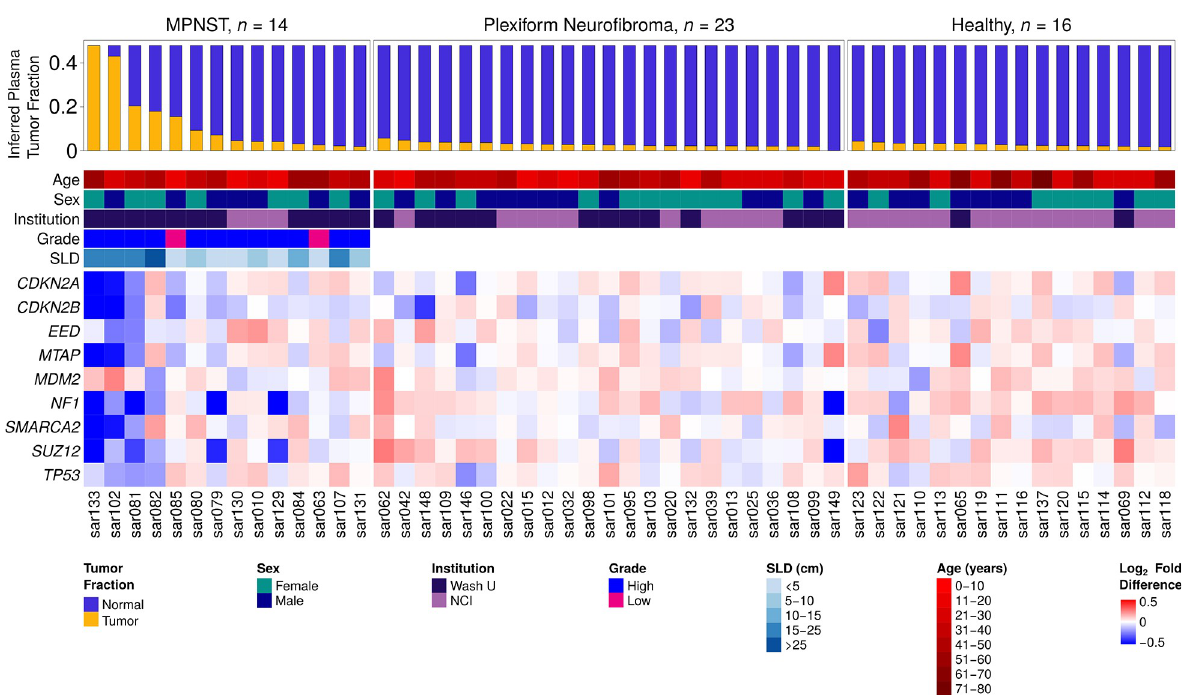
Fig 2. Participant characteristics and CNAs. Heatmap includes all 53 participants in this study, categorized by diagnosis. Each column represents one study participant with ID labels shown below. Highest tumor fraction in plasma and important tumor and participant characteristics are displayed in the top panel. The lower panel shows CNAs in genes relevant to NF1 and MPNST pathogenesis, depicted as log 2 of copy number ratio. CNA, copy number alteration; MPNST, malignant peripheral nerve sheath tumor; NF1, neurofibromatosis type 1; SLD, sum of longest tumor diameters as determined by RECIST 1.1